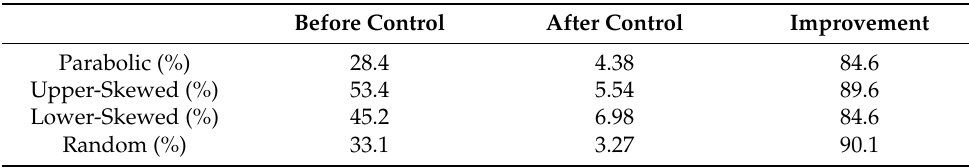
Table 6. Summary of NH 3 /NO uniformity by AIG flow control. Before